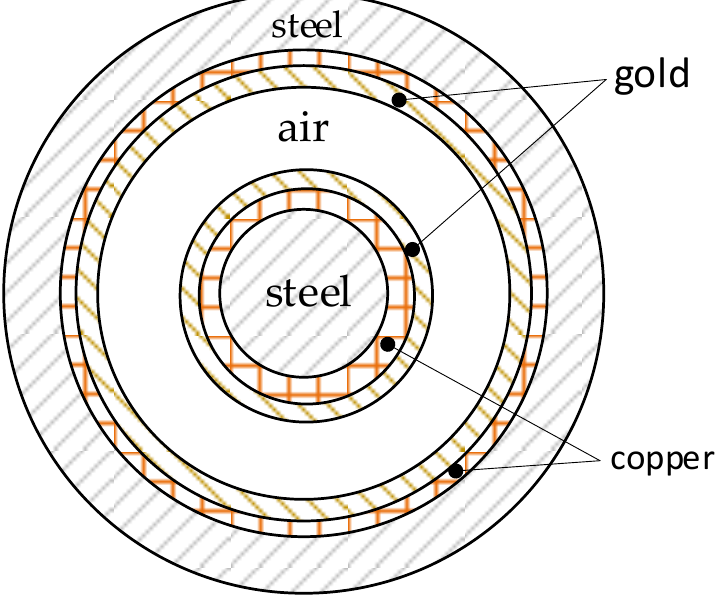
Figure 3. Cross-section of the multilayer waveguide considered in the first validation example. This waveguide is assembled from two coaxial cylindrical conductors. The central part of the internal structure is a wire with a radius of 0.7 mm, made of stainless steel with a relative permeability equal to 1.02 and electrical conductivity of 1.32 · 10 6 S/m. The first layer is assumed to be equal to 10 µ m thick copper, whose relative permeability is considered to be 0.99994 and electrical conductivity is 5.96 · 10 7 S/m. The second material is 5 µ m thick gold whose relative permeability is equal to 0.999966 and electrical conductivity is 4.4 · 10 7 S/m. The relative permittivity was assumed to be equal to unity for all the materials used. The outer cylindrical conductor is made of the same materials as the inner but in reverse order: the first (counting from the inside) is 5 µ m thick gold, then 10 µ